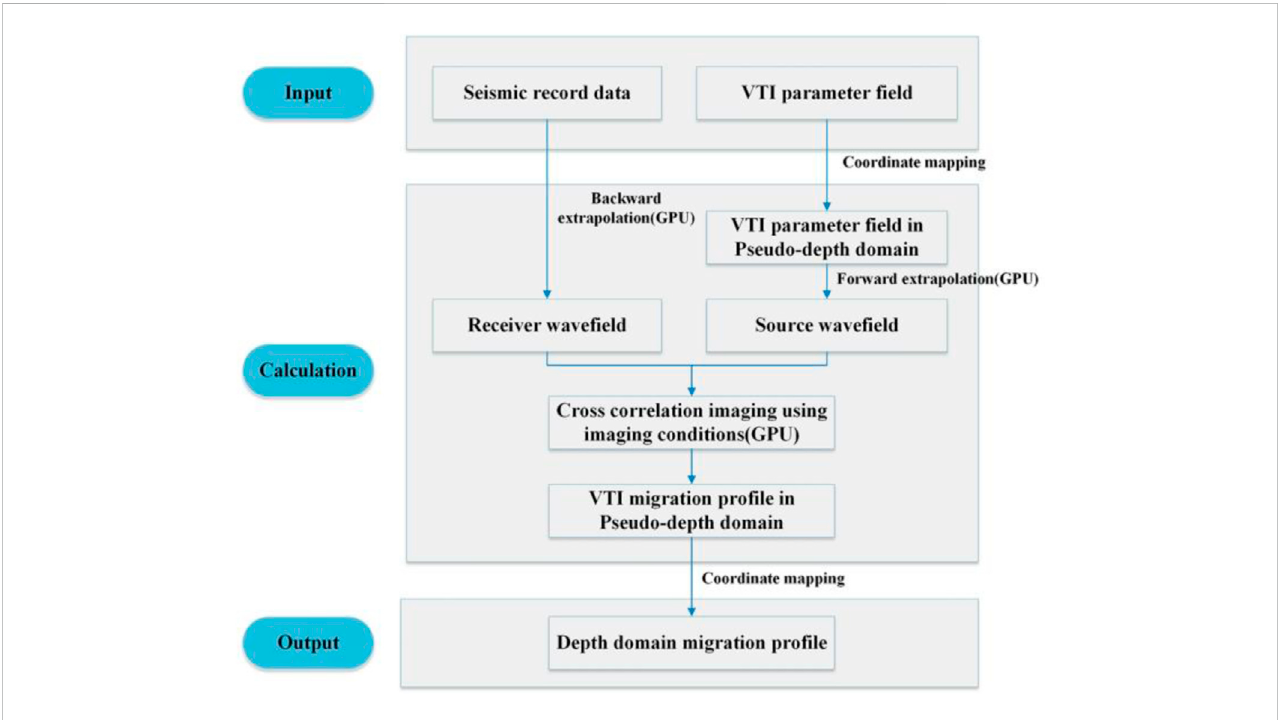
FIGURE 3 VTI pseudo-depth domain reverse time migration based on GPU parallel accelerated work fl ow.